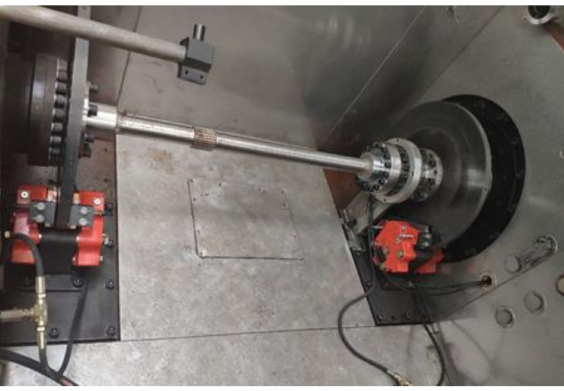
Figure 3. Mechanical brake